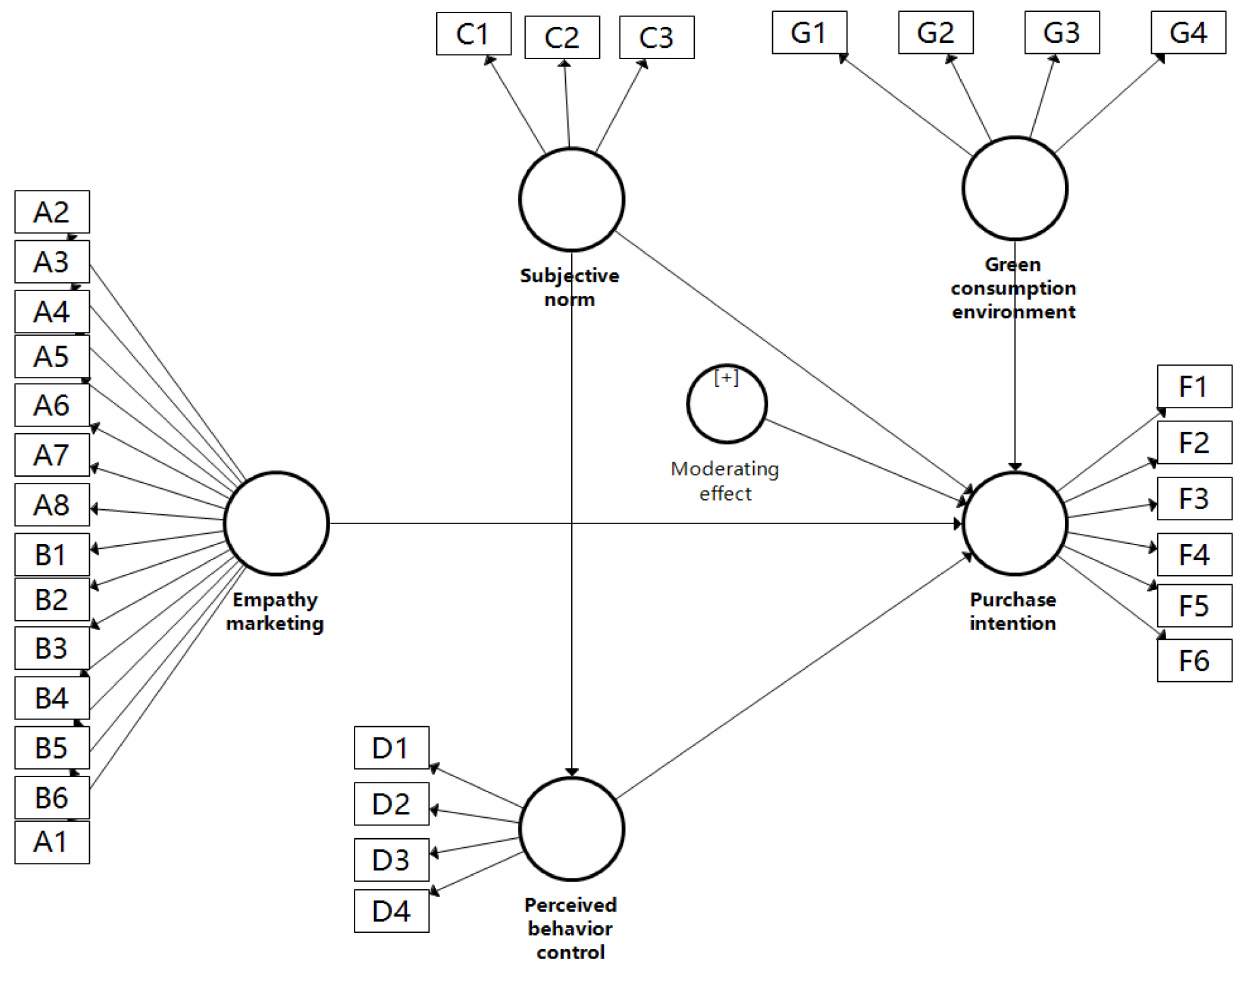
FIGURE 2 | Preliminary model